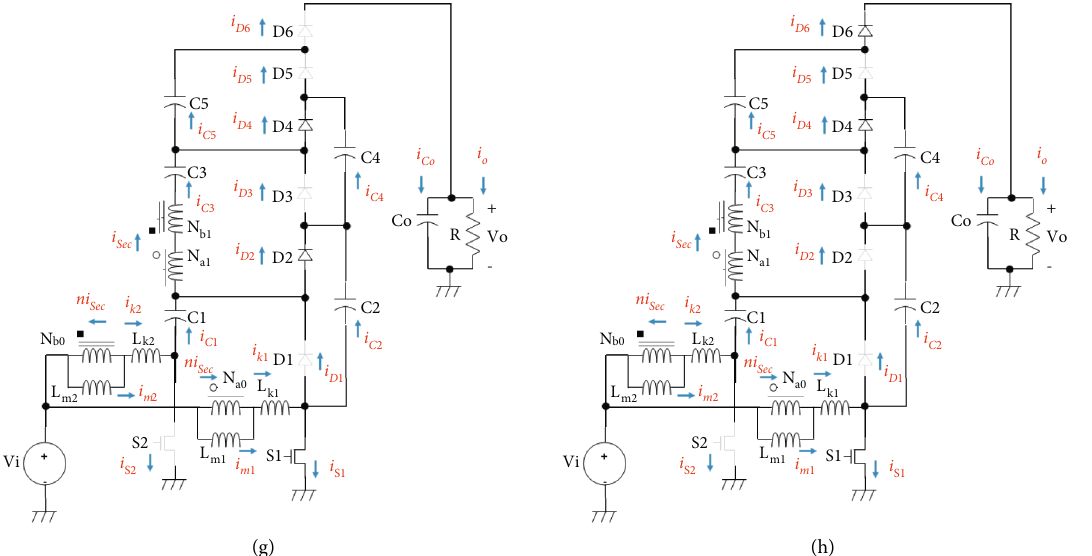
0 -t 1 ]; (b) mode 2 [t 1 -t 2 ]; (c) mode 3 [t 2 -t 3 ]; (d) mode 4 [t 3 -t 4 ];